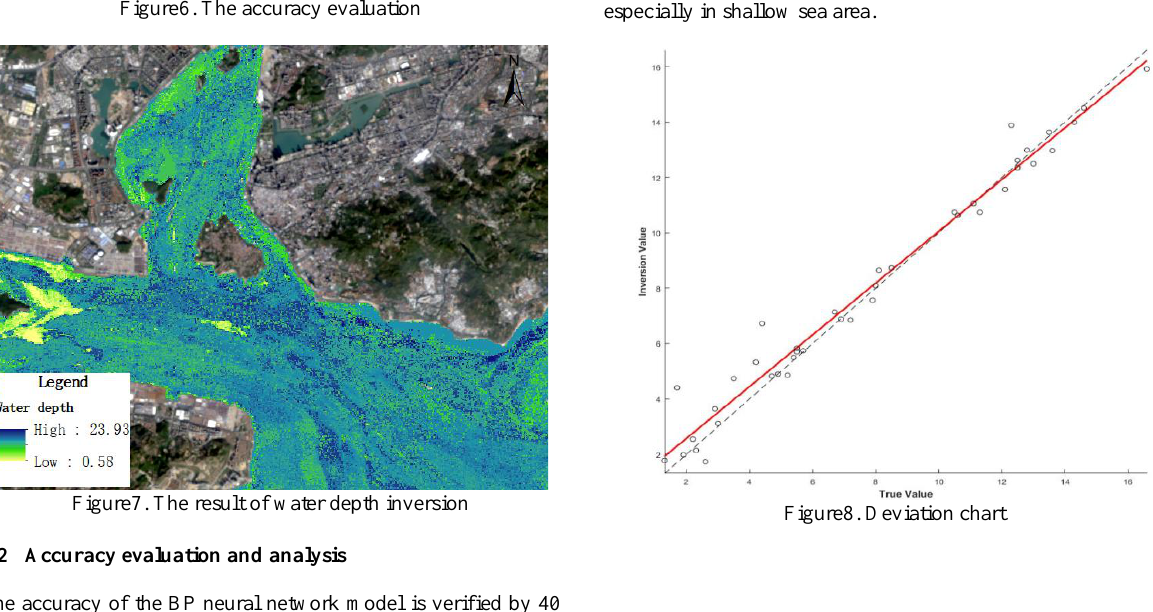
Figure6. The accuracy evaluation